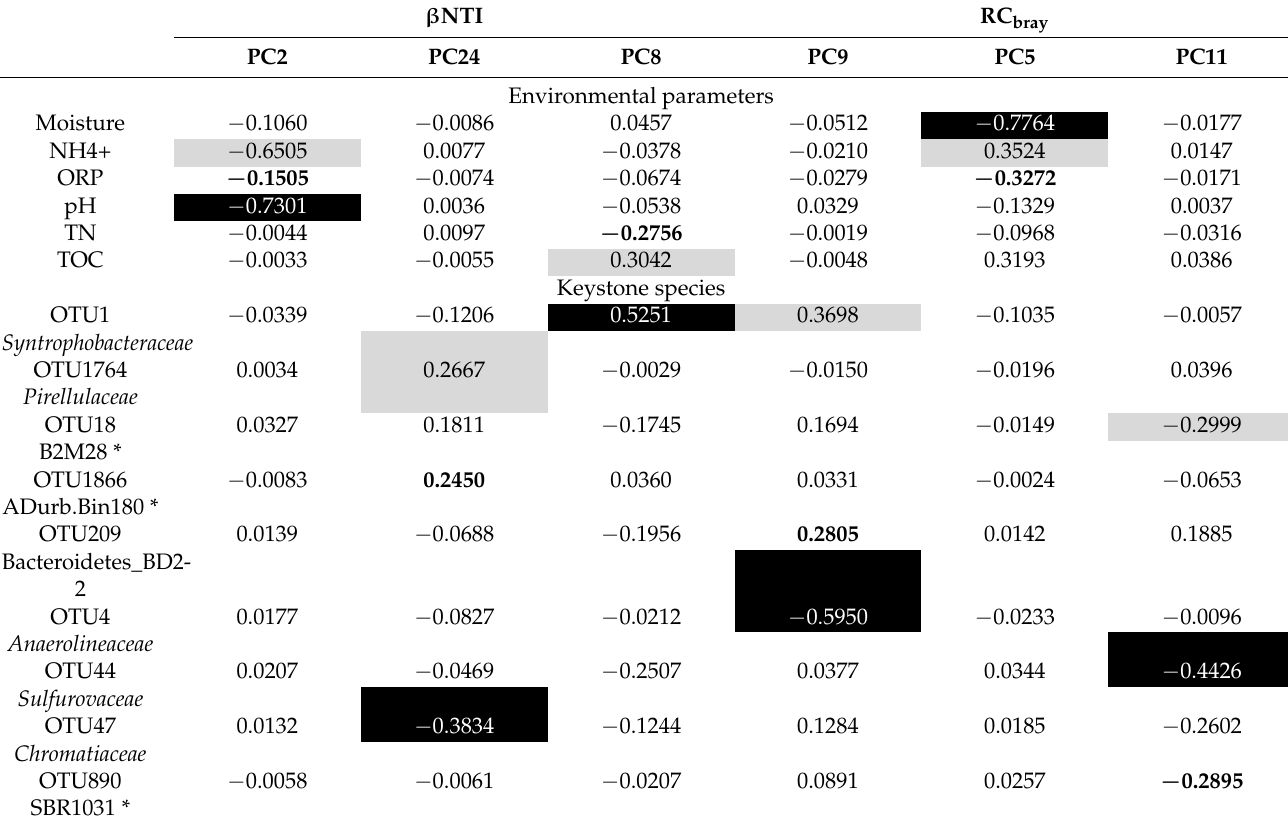
Table 1. The retained PCA axes through β NTI and RC bray model selection and loadings. β